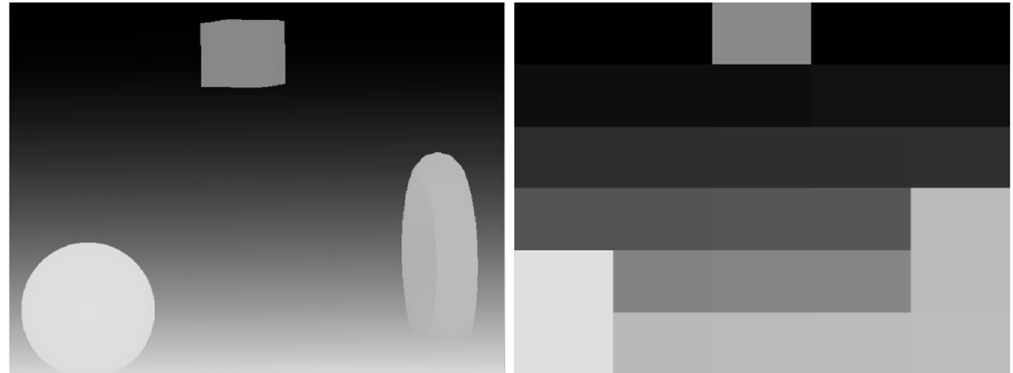
Figure 4. On the left , generated depth map for the sample scene. On the right , a map of the depth of the scene with a resolution reduced to 6 × 5 px. Images are intended to show only the difference in the reception of different resolutions and do not include the dynamics of the device.